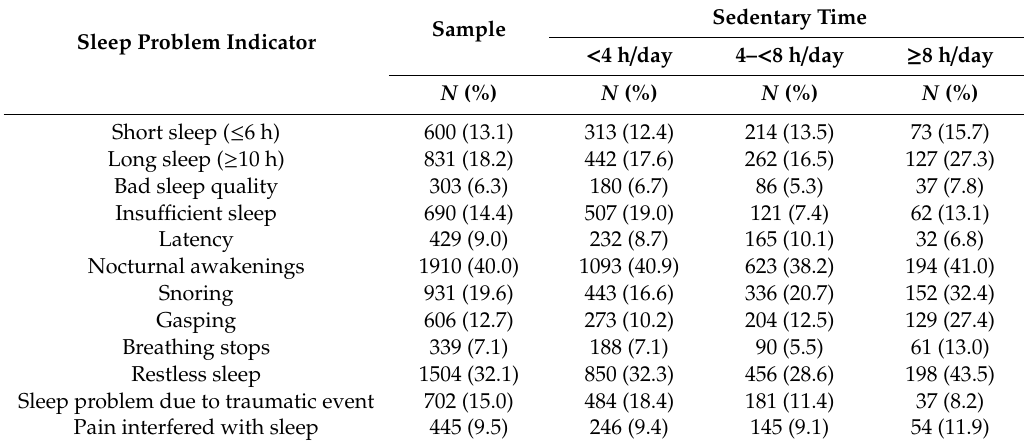
Table 1. Sample characteristics by sleep problem indicators and sedentary time.